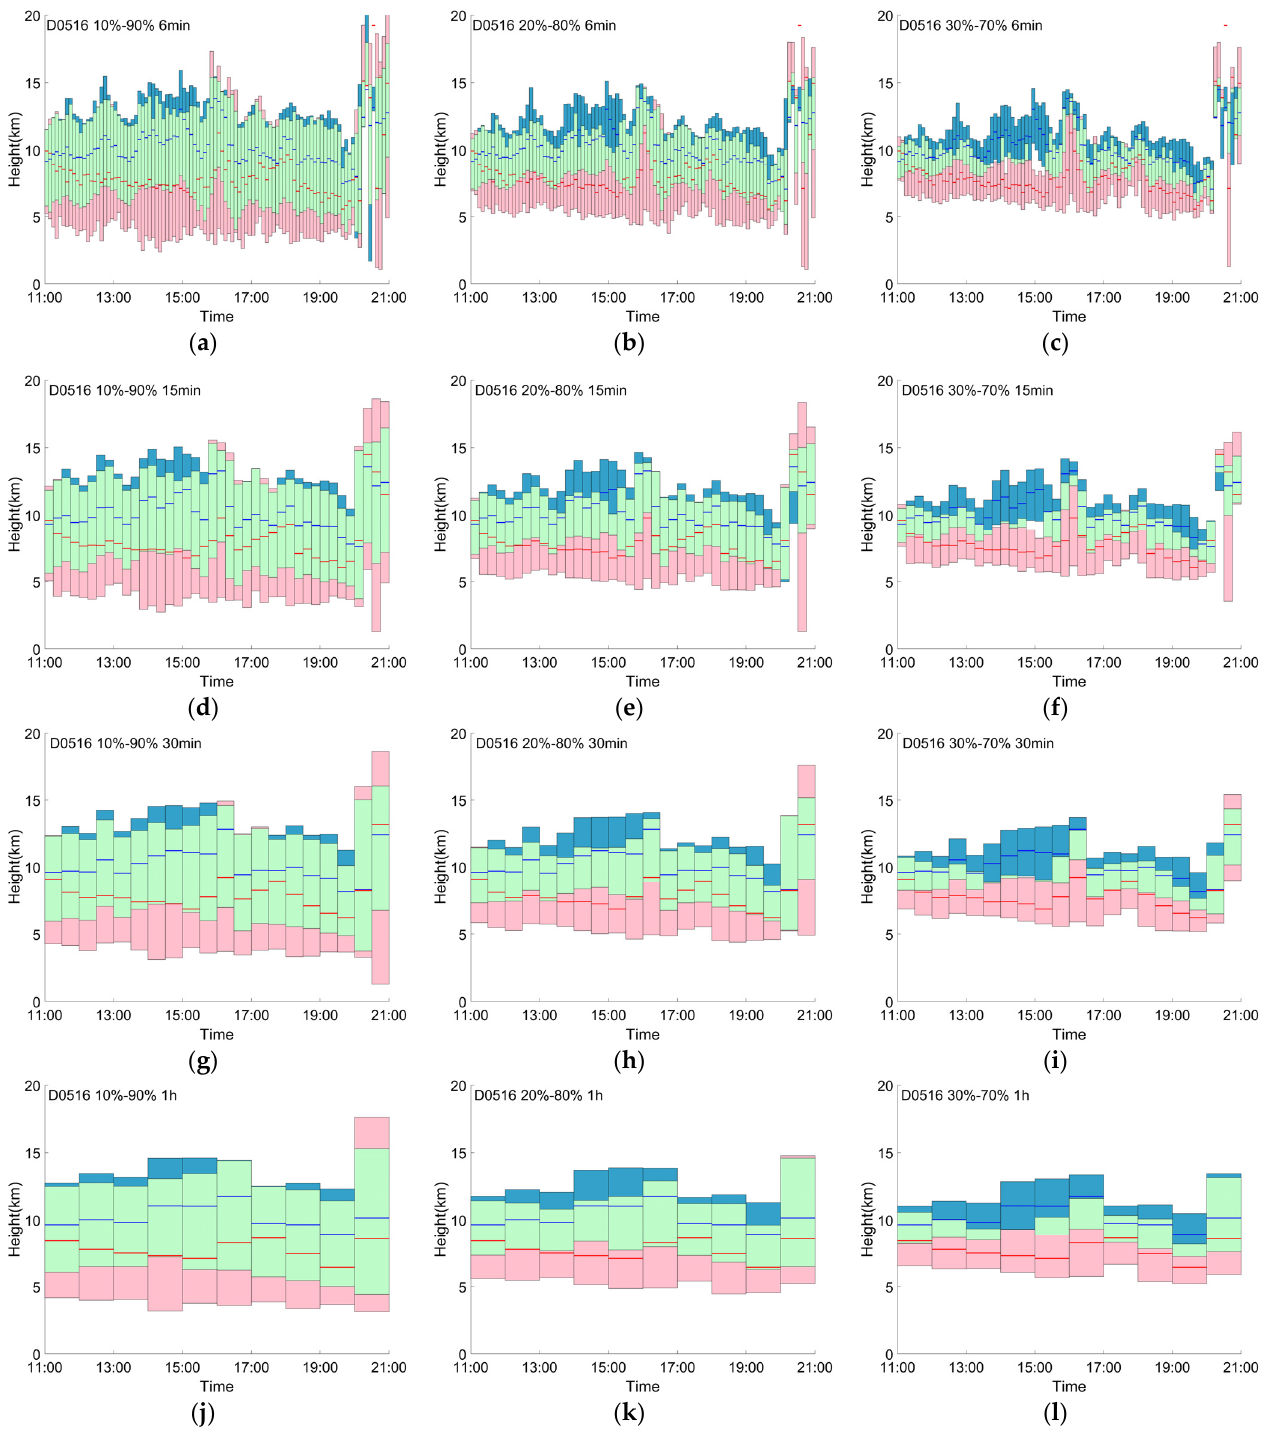
Figure 5. Electrical structure on 16 May: ( a – c ) The height range of positive and negative IC events versus time with three types of proportions every 6 min for 10 h within the area of 300 km × 300 km. ( d – f ) Same, except with the time interval of 15 min. ( g – i ) Same, except with the time interval of 30 min. ( j – l ) Same, except with the time interval of 1 h. The pink part denotes sources in the region with only negative IC events, and the blue part with only positive IC events. The green part denotes sources with both positive and negative IC events. The red solid lines represent the median height of the sorted negative IC events, and the blue solid lines represent the median height of the sorted positive IC events.